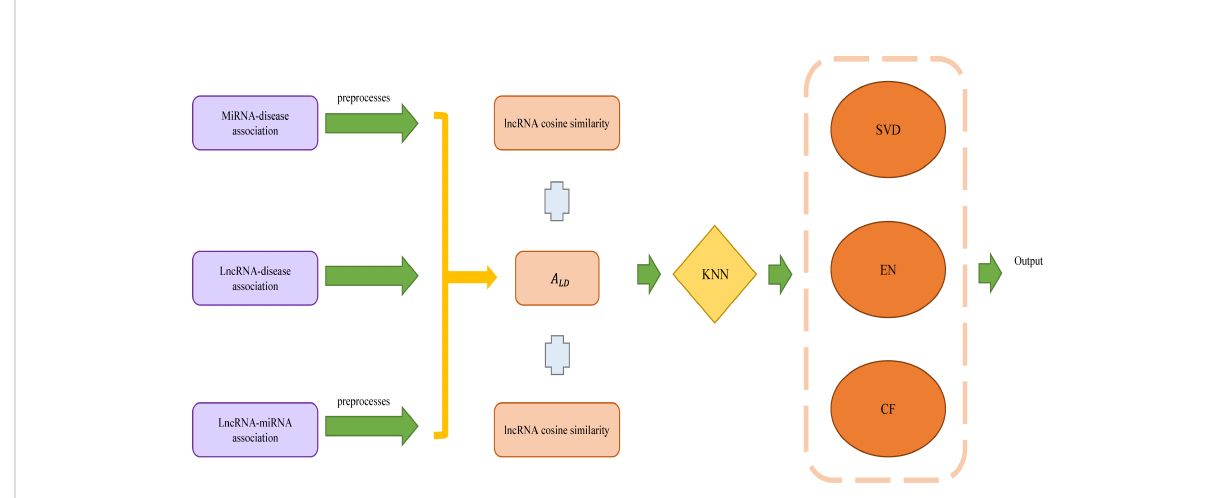
FIGURE 5 The fl owchart of ENCFLDA to predict the association of lncRNAs with diseases based on elastic network, matrix decomposition and collaborative fi